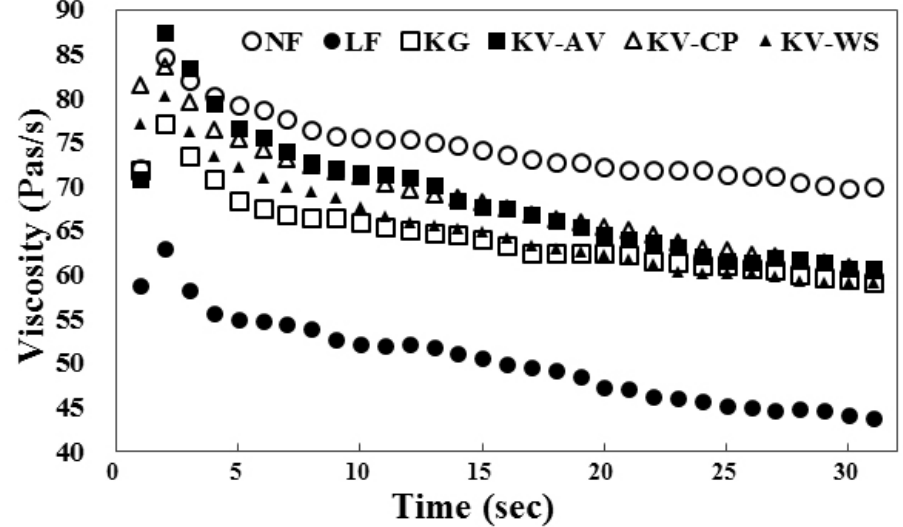
Figure 2. Apparent viscosity of frankfurter sausages. Groups of frankfurter sausage: NF, normal-fat frankfurter sausage formulated with 20% ice and 20% fat; LF, low-fat frankfurter sausage formulated with 30% ice and 10% back fat; KG, frankfurter sausage formulated with 10% konjac gel and 10% back fat; KV-AV, frankfurter sausage formulated with 10% konjac gel with aloe vera vegetable powder and 10% back fat; KV-CP, frankfurter sausage formulated with 10% konjac gel with cactus pear vegetable powder and 10% back fat; KV-WS, frankfurter sausage formulated with 10% konjac gel with wheat sprout vegetable powder and 10% back